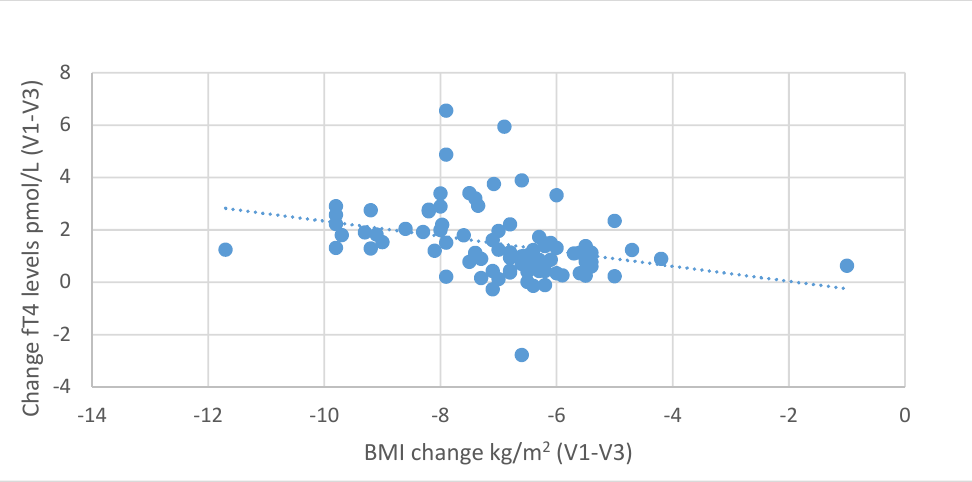
Figure 7. Correlations between differences in BMI and changes in serum fT3 levels (between initial visit V1 and final visit V3).